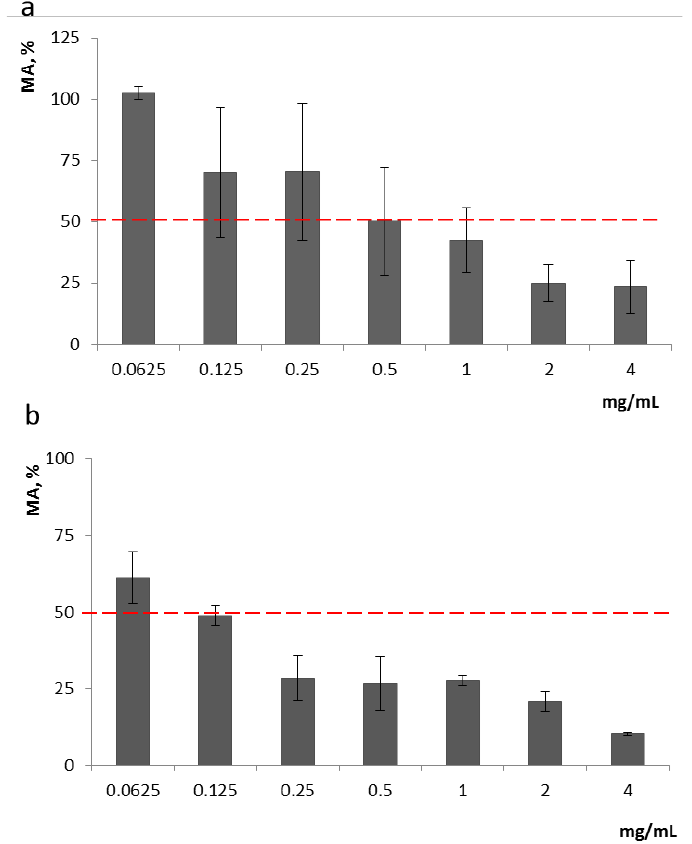
Figure 1. Inhibition of F. proliferatum MA by Ch1 ( a ) and Ch2 ( b ); 100% was taken as the growth of fungus in the control (without the addition of chitosan). Ch1, as can be seen from the graph, began to inhibit the growth of the strain from a concentration of 0.125 (up to 30% of inhibition), while Ch2 began to inhibit growth from a concentration of